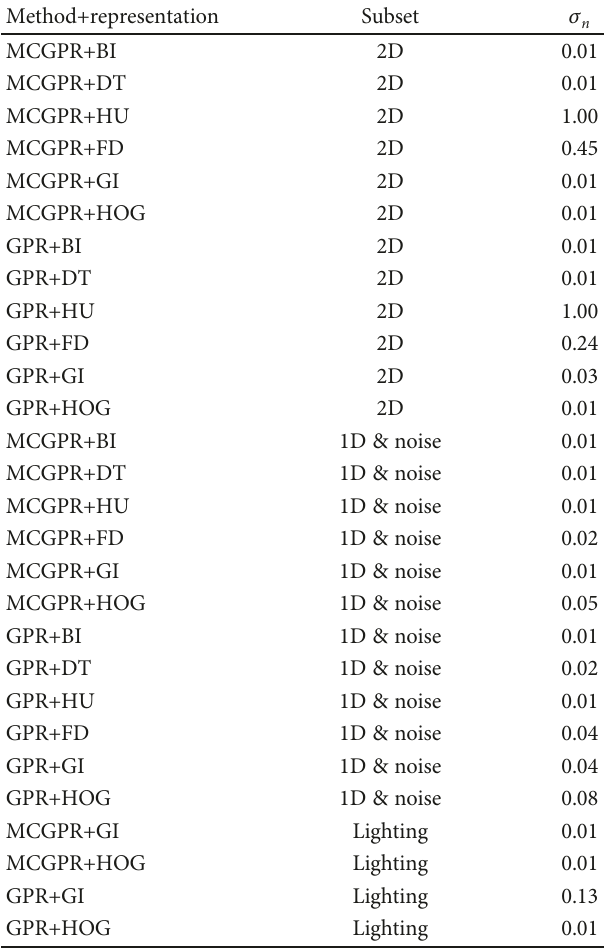
Table 9: Parameters used for pose